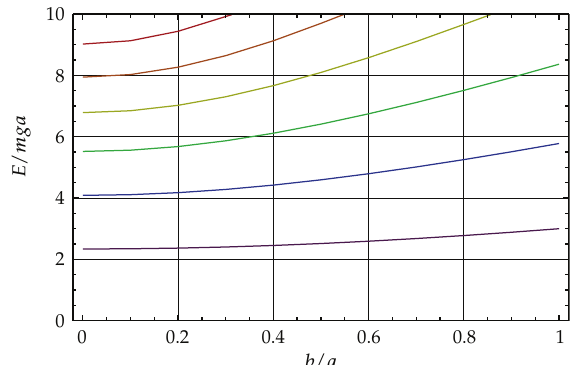
Figure 4: The b dependence of the lowest energy levels of a particle of mass m in a linear gravitaional potential V (cid:5) x (cid:6) (cid:4) mgx with x > 0. a (cid:4) (cid:2) (cid:2) 2 / 2 m 2 g (cid:3) 1 / 3 is the characteristic length scale of the system, and (cid:2) β is the minimal length. b (cid:4) (cid:2)